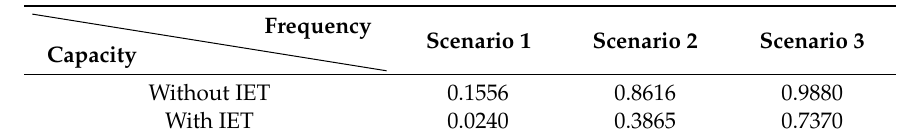
Table 6. Comparison of